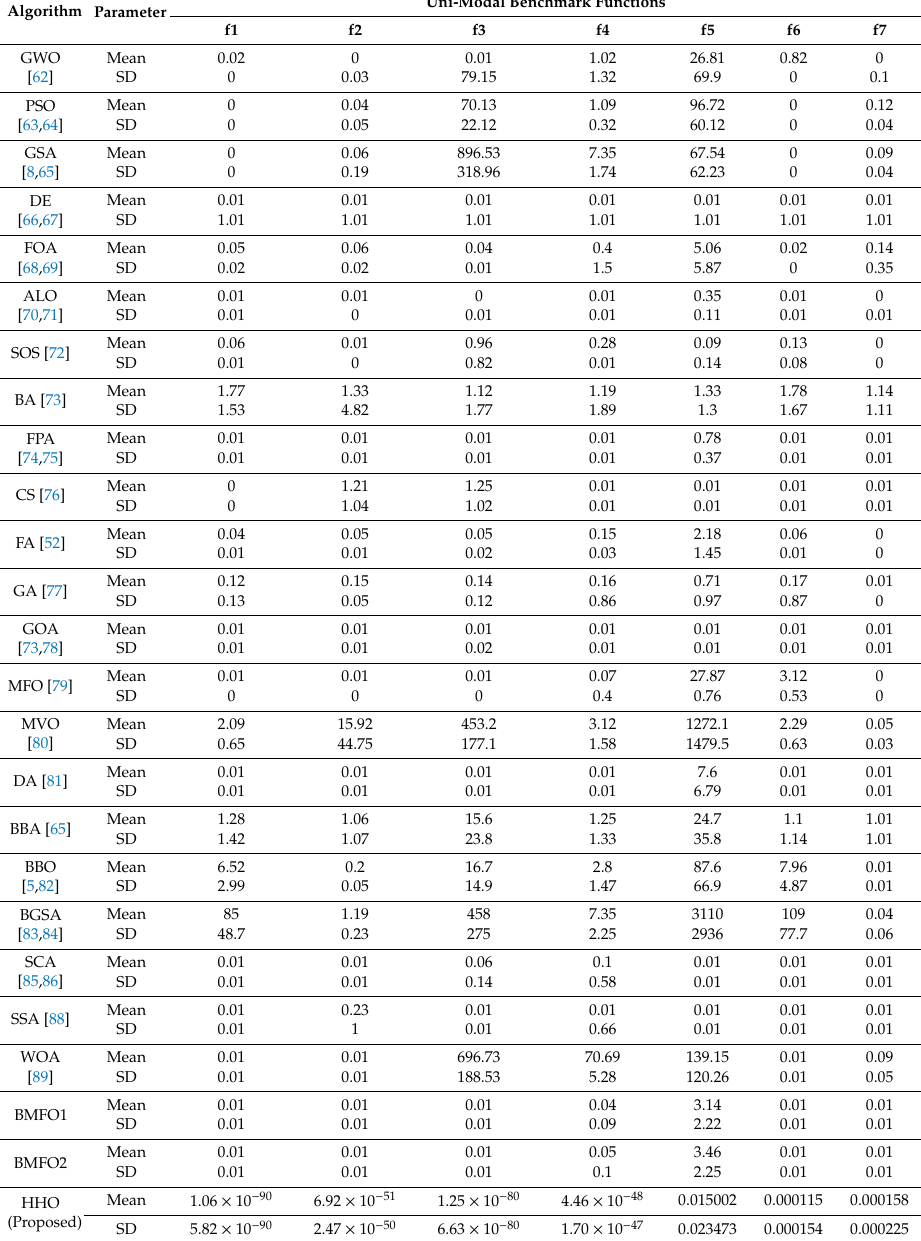
Table 5. Comparison of unimodal benchmark functions. Algorithm Parameter Uni-Modal Benchmark